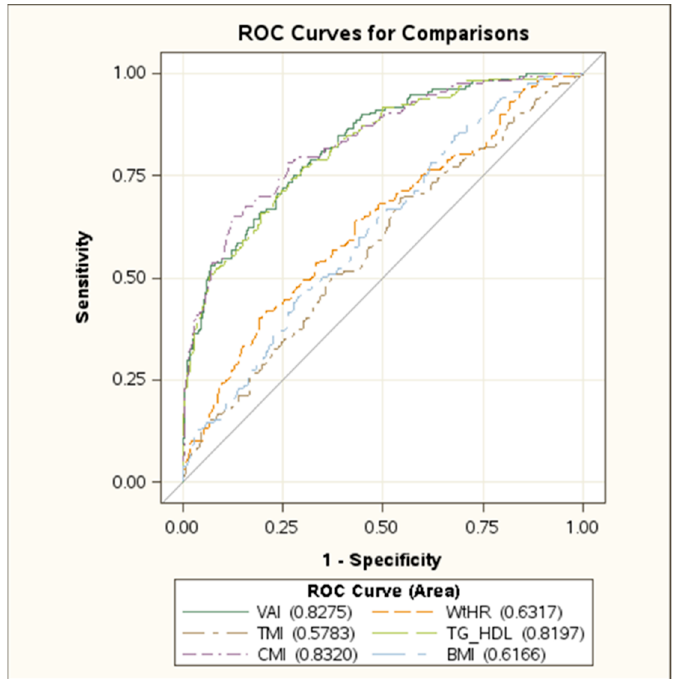
Figure 2. ROC curve in girls. Abbreviations: VAI: Visceral Adiposity Index; WtHR: Waist-to-Height ratio; TMI: Tri-Ponderal Mass Index; TG/HDL: triglyceride to high density-lipoprotein cholesterol ratio; CMI: Cardiometabolic Index; BMI: Body Mass Index.